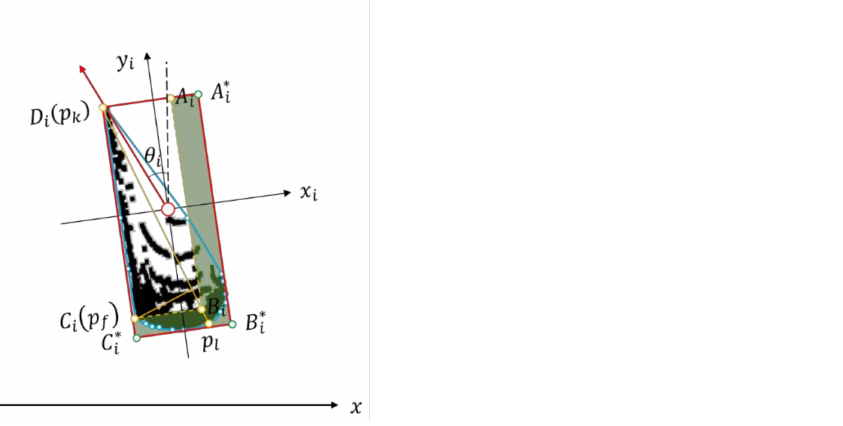
Figure 10. Illustration of the DPCA algorithm. The red dotted line represents the uncorrected bounding box, the red line box represents the final bounding box, and the green part represents the corrected